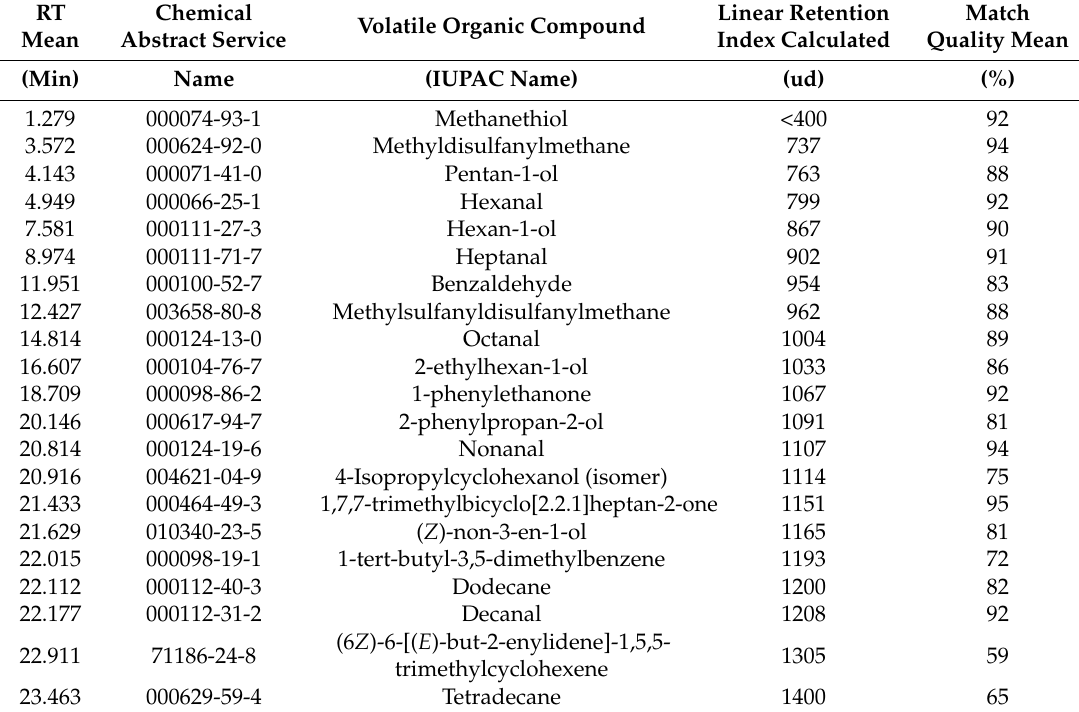
Table 1. Main volatile organic compounds extracted by headspace solid phase microextraction, measured by gas-chromatography coupled to mass spectrometry and tentatively identified by deconvolution analysis versus NIST11 database. Chemical compound were identified in more than 90% of the melon fruit samples analyzed (outliers excluded from the calculations) in order of retention time. The column used was an HP-5MS